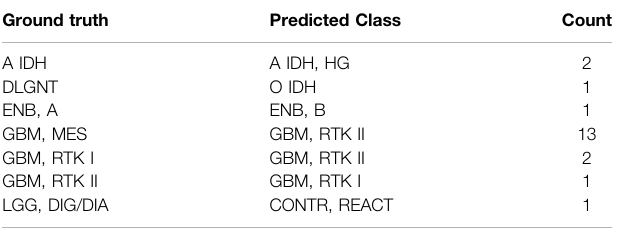
TABLE 1 | The incorrect prediction result in the training set. The fi rst column is the true label, the second column is the predicted result, and the third column is the number of the corresponding samples.